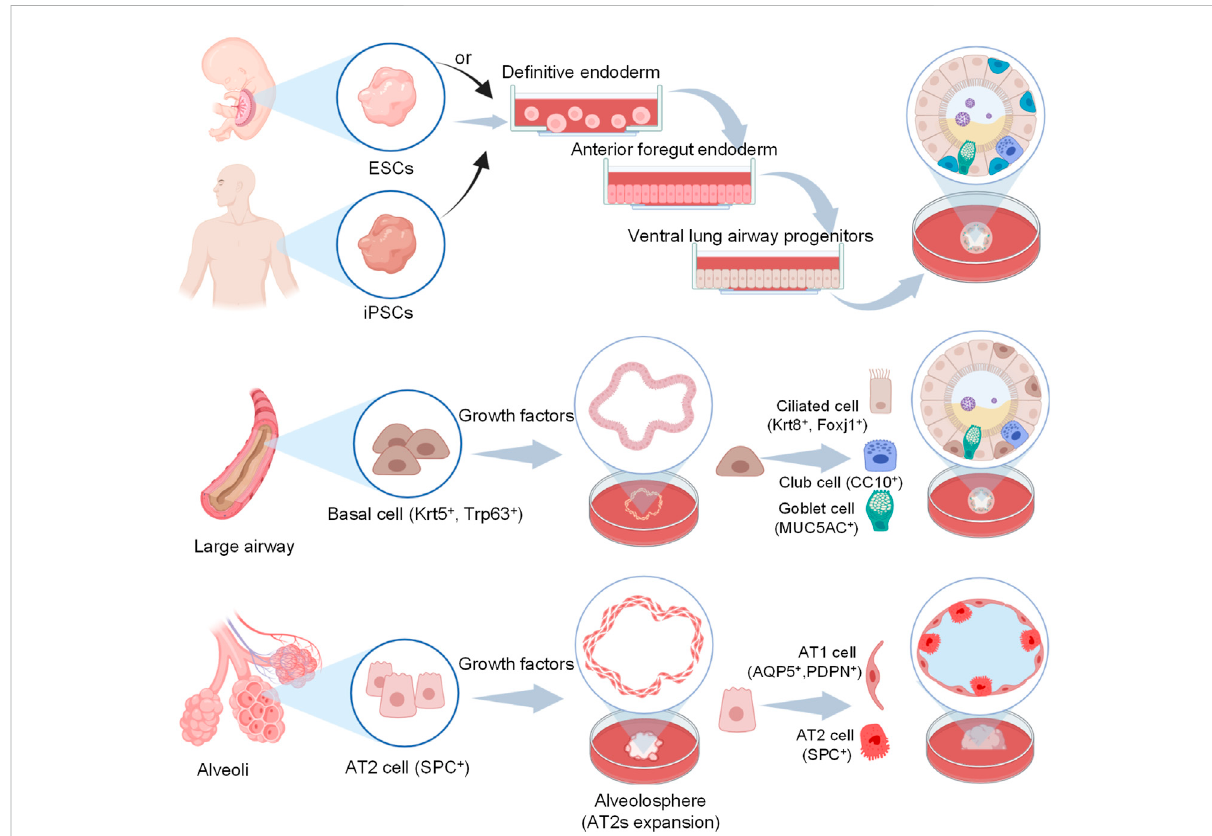
FIGURE 2 Schematic representation of human airway and alveoli organoids developed from different origin cells and cultivation include particular steps. For iPSCs, they fi rst generate de fi nitive endoderm (DE), then anterior foregut endoderm (AFE) and lung progenitors (LPs) with different additives, fi nallyyieldlungorganoids via 3DcultureusingMatrigel(Barkauskasetal.,2017).ForbasalcellsandAT2cells,theymaintainundersuitableconditions and self-organize in a more natural manner with